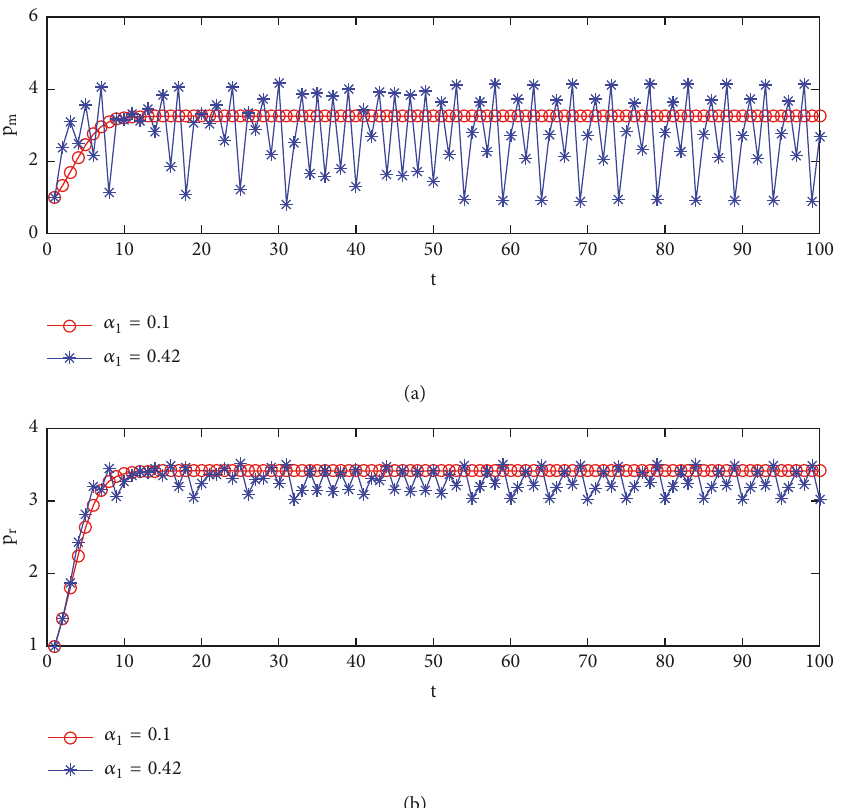
Figure 11: Power spectrum of the system when 𝛼 1 = 0.42,𝛼 2 = 0.1 : (a) change for 𝑝 𝑚 along with the time; (b) change for 𝑝 𝑟 along with the